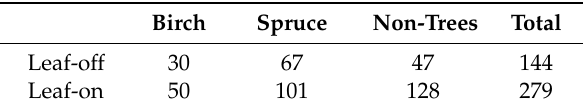
Table 4. Number of training data in each classification class in each epoch. Non-tree classes include stump / deadwood, bush / grass / fern, and rock. Birch Spruce